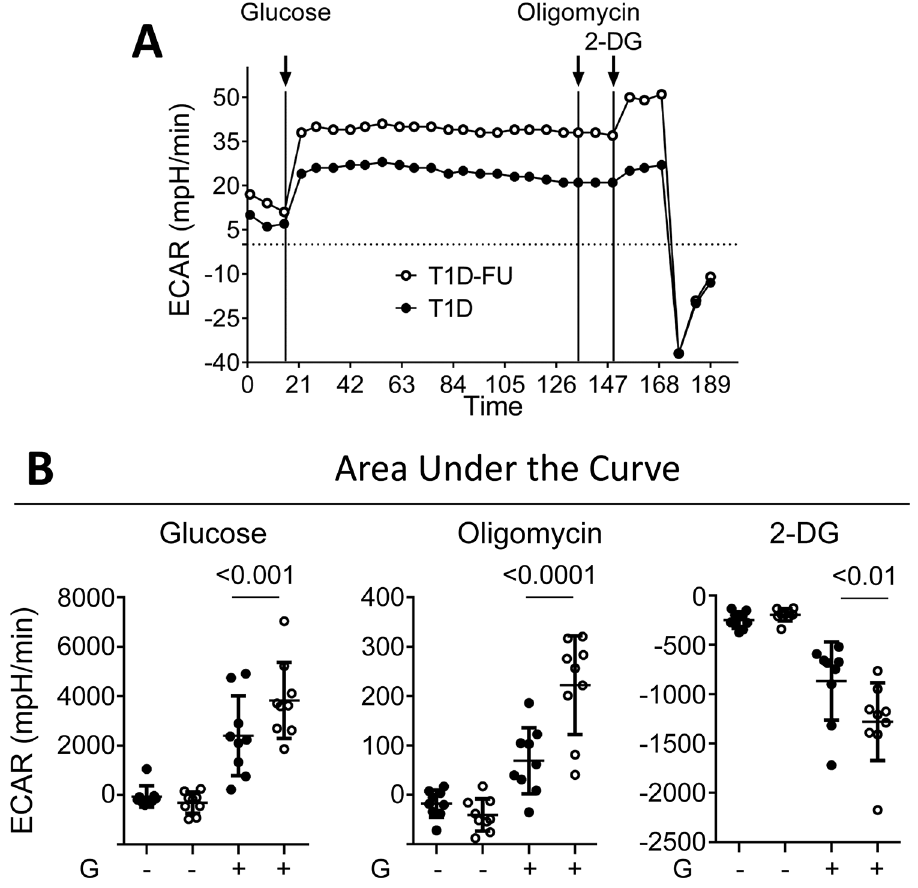
Fig 4. PBMCs from T1D follow up had enhanced glycolytic capacity compared to T1D. A . ECAR (mpH/ min) in PBMCs from T1D (black circles) and T1D Follow up (open circles) after addingglucose,oligomycin and 2-DG. B . Integration of area under the curve showingcomparisons in ECAR betweenT1D and T1D Follow up with additives,as shown.